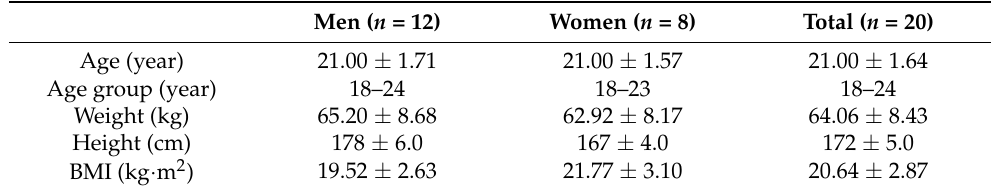
Table 1. Anthropometric characteristics of the subjects.